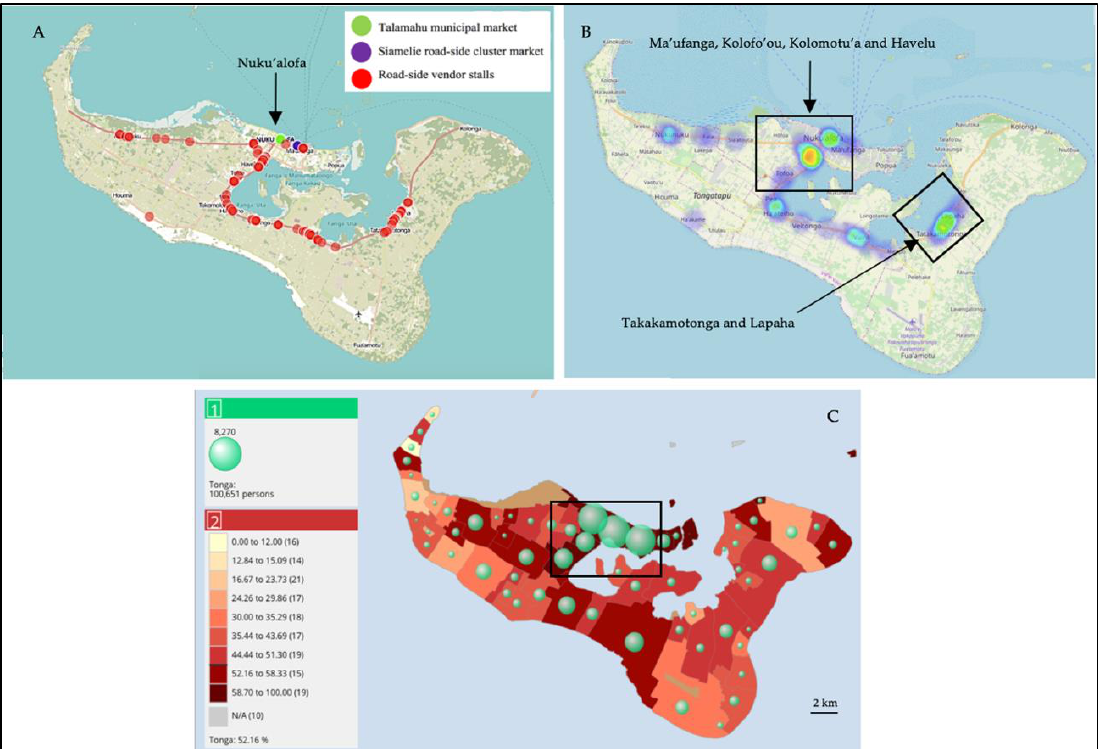
Figure 2. ( A ) The location of commercial fresh fruit and vegetable vendors on Tongatapu Island, Tonga. ( B ) Heat map of road-side markets on Tongatapu Island (colour intensity is proportional to the number of vendor stalls in a given location). ( C ) Households on Tongatapu Island not producing crops for sale or home use, with population density overlay. Map source: ( A , B ) Openstreet map and KoBoToolBox ™ with survey data overlays. ( C ) PopGIS Tonga 2016 Population and housing census data. Tonga Department of Statistics.